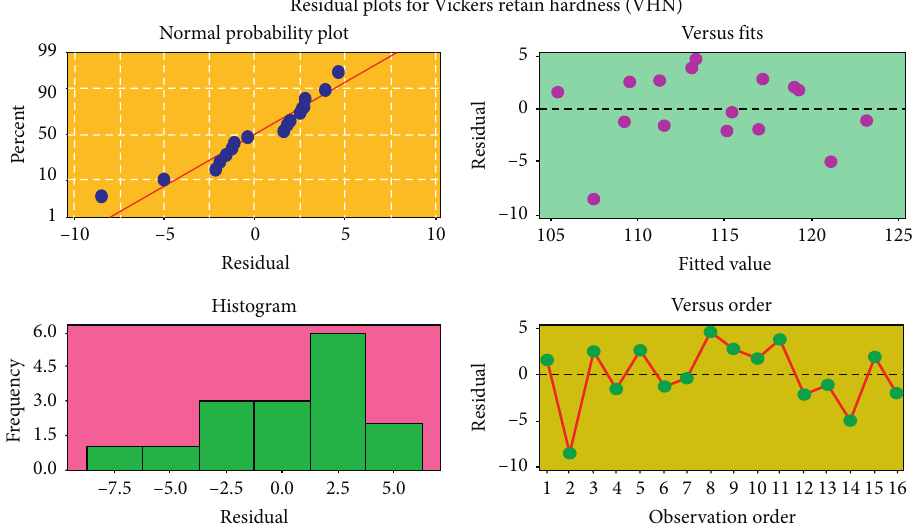
Figure 13: Residual plots for Vickers